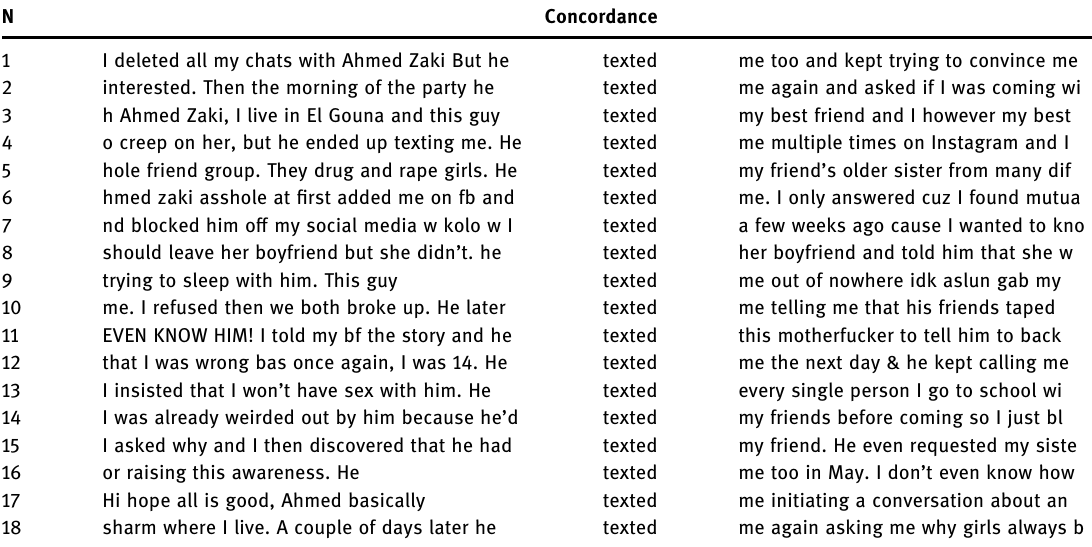
Table 40: Concordance lines for texted